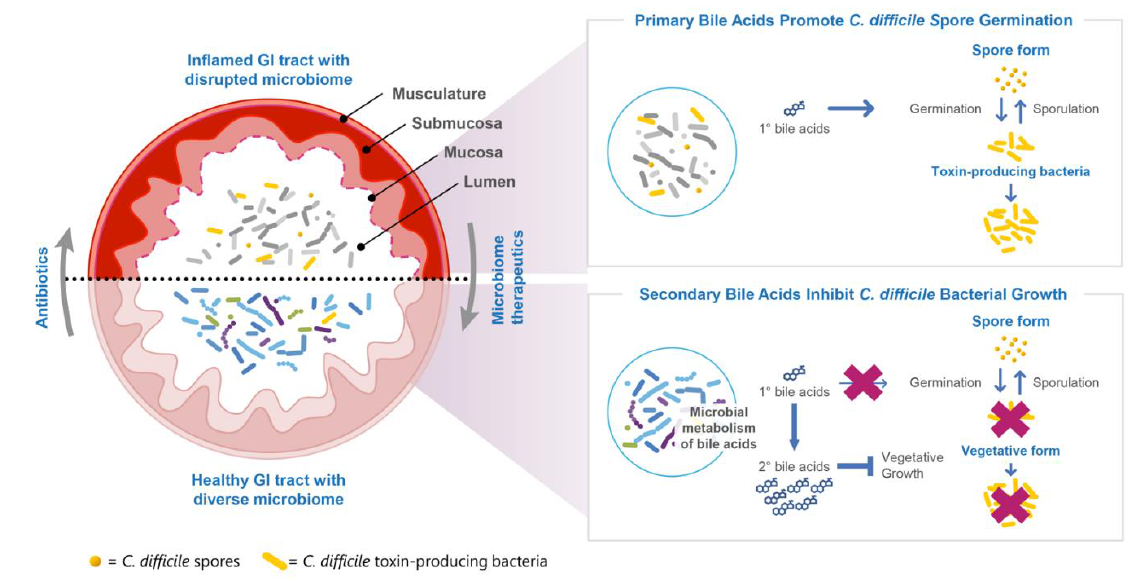
Figure 3. SER-109 engraftment and metabolomics.